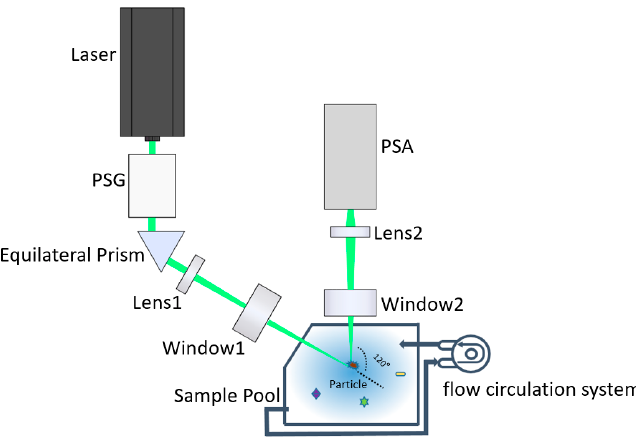
Figure 1. Schematic diagram of the optical system of the experimental setup. Lens 2 consists of a series of lenses and a pinhole. The size of the pinhole is